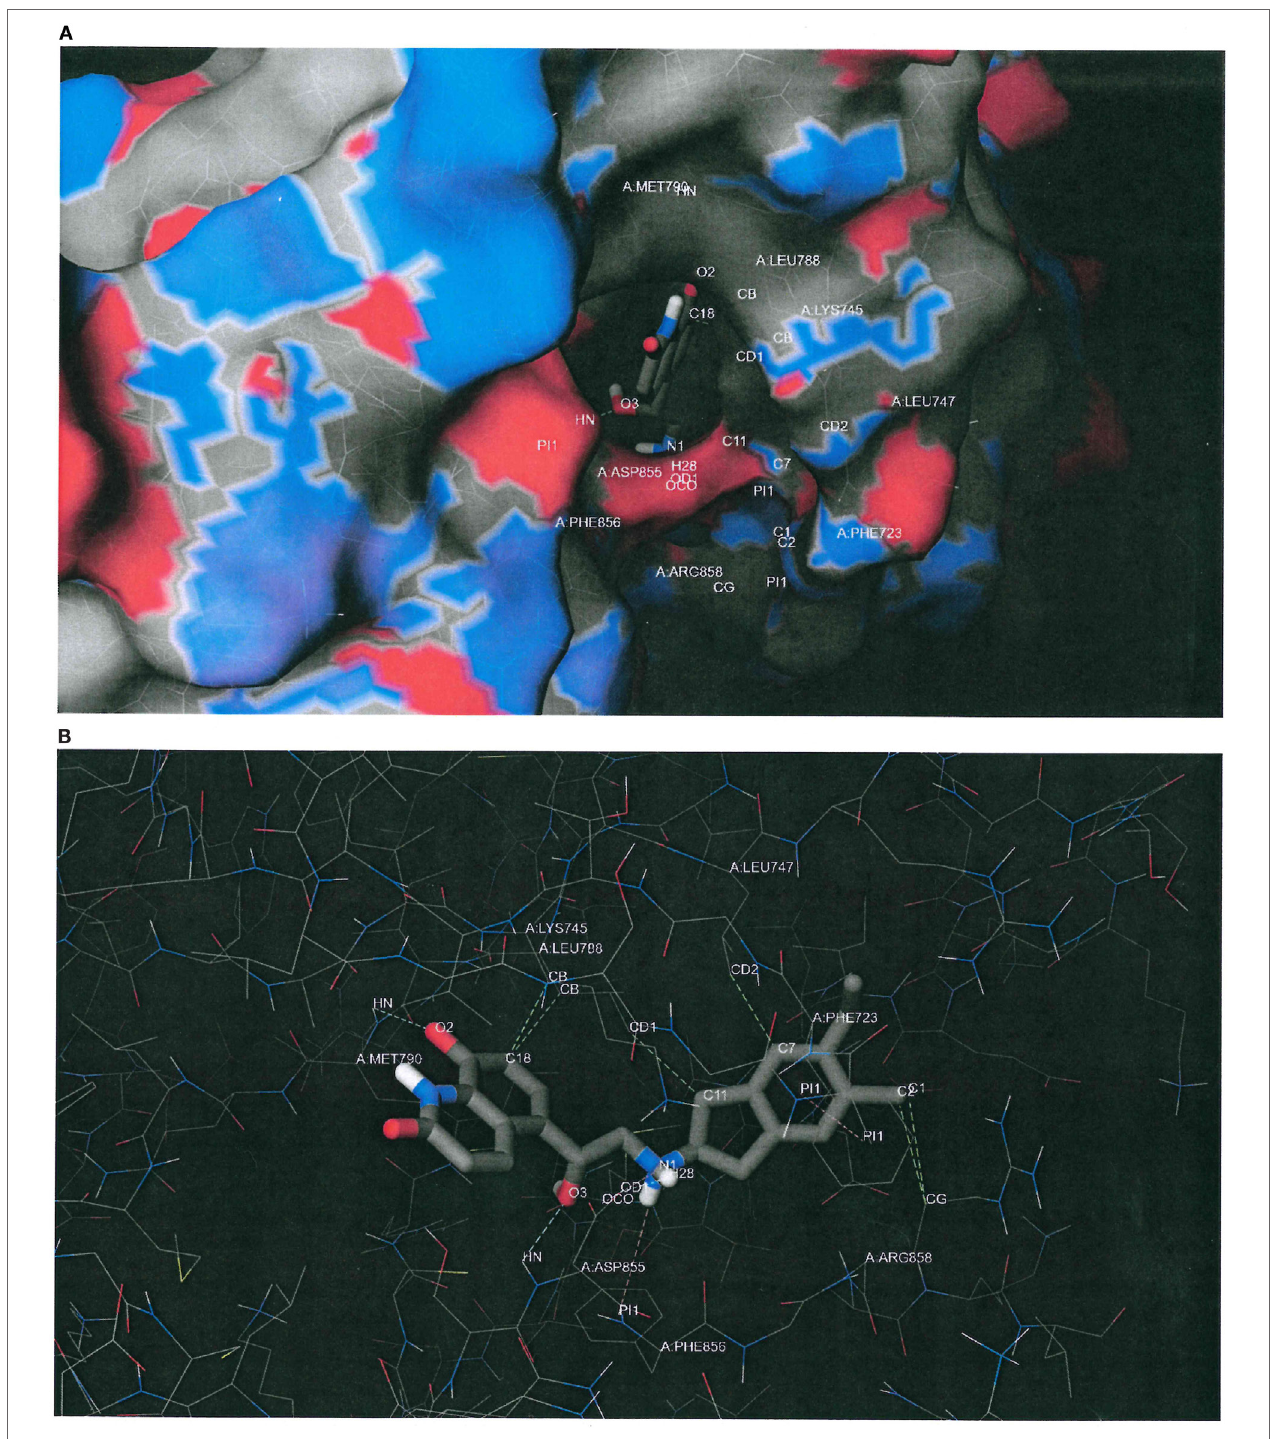
FigUre 6 | Putative binding conformation of indacaterol to epidermal growth factor receptor (EGFR) L858R/T790M active site (PDB ID 3W2R). (a) The putative binding pose of indacaterol on the macromolecular surface of EGFR L858R/T790M as predicted by the docking software. Carbons, oxygens, nitrogens, and sulfurs were rendered in gray, red, blue, and yellow, respectively. It can be seen that the indacaterol molecule was buried deep down in the binding pocket, with an oxygen atom acting as a hydrogen-bond acceptor and creating a hydrogen bond with the donor atom of the backbone of “gatekeeper” MET790. (b) The same predicted conformation of indacaterol upon binding to EGFR L858R/T790M, but with the macromolecular surface hidden in order to better inspect the putative intermolecular interactions, depicted by dashed lines. In addition to the hydrogen bond with MET790, indacaterol was predicted to establish two hydrogen bonds with ASP855 (cyan color), a salt bridge with ASP855 (purple color), a parallel displaced π stacking with PHE723 (pink color), a cation– π interaction with PHE856 (pink color), and some hydrophobic contacts with LYS745, LEU747, LEU788, and ARG858 (green color).